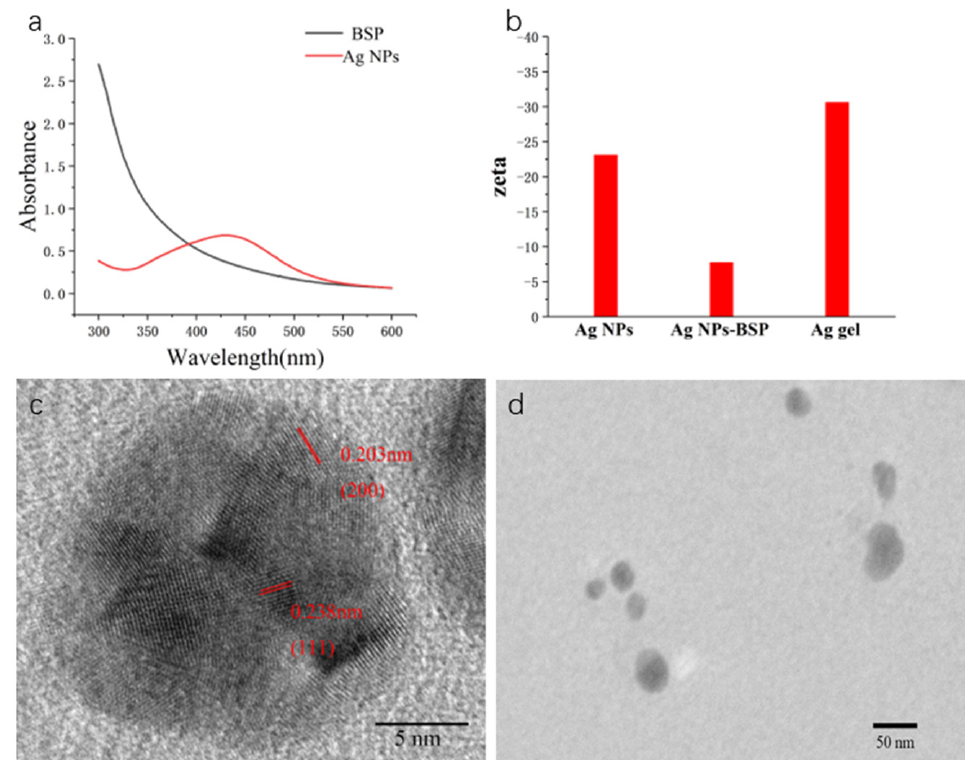
Figure 2. ( a ) UV–vis absorption spectra of Ag nanoparticles and Bletilla striata polysaccharide (BSP). ( b ) the zeta potential of Ag nanoparticles washed (named Ag NPs), Ag nanoparticles synthesized by BSP (named Ag NPs-BSP) and Ag nanoparticles carbomer gel (named Ag gel). ( c , d ) TEM and high-resolution image of Ag NPs.